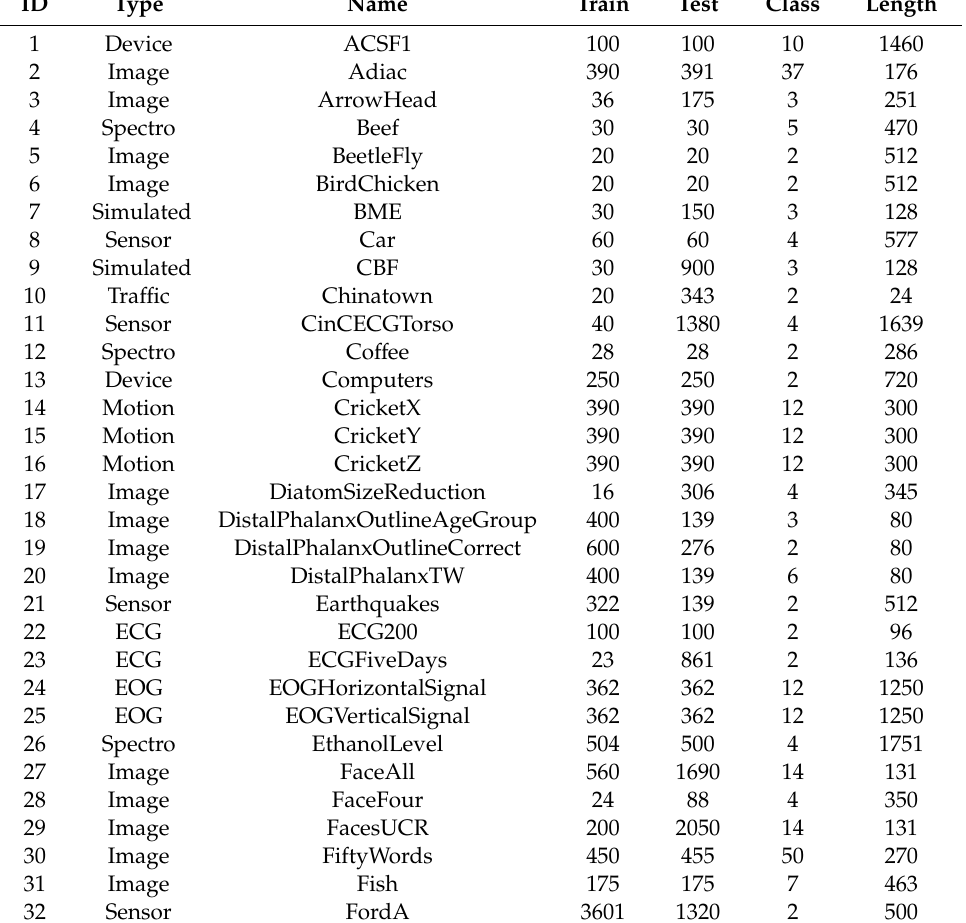
Table 2. 100 di ff erent types of time series